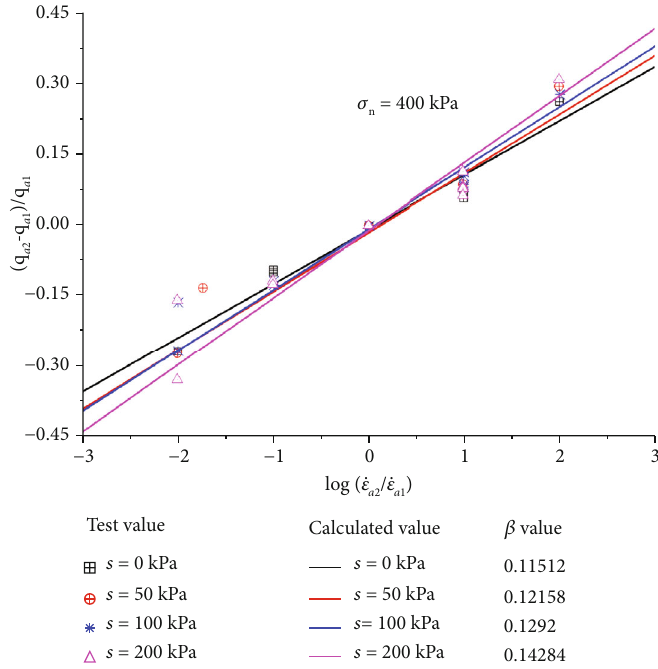
Figure 8: β value of reticulate red clay with di ff erent matric suction ( σ